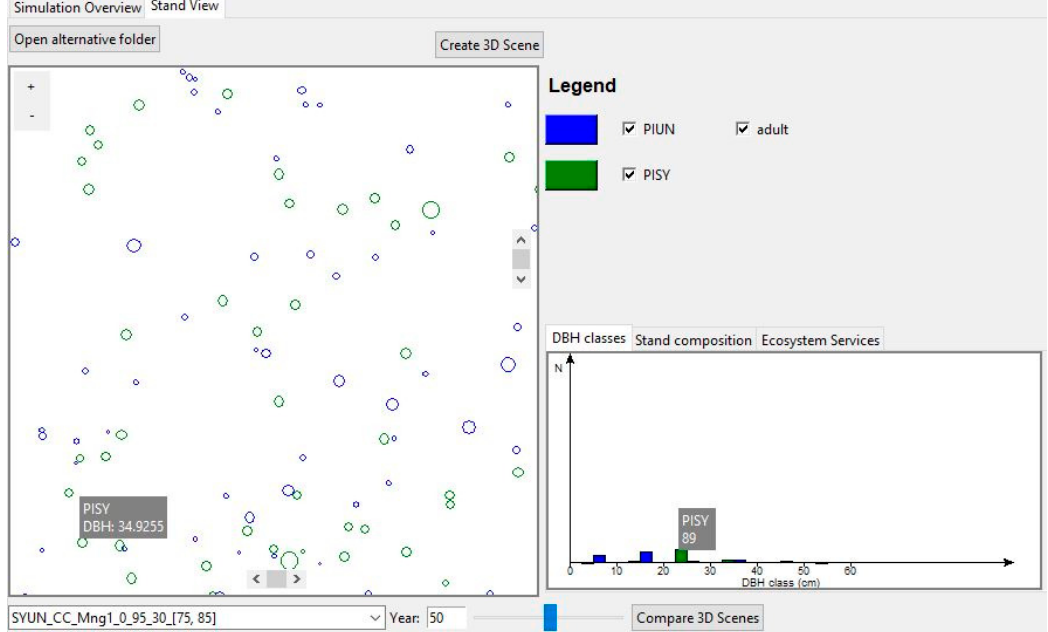
Figure 9. Visualization interface. The detailed view tab incorporates an interactive 2D map of the stand, and additional information such as tree DBH distribution is organized in interactive bar charts as well as tables showing the stand composition and ecosystem